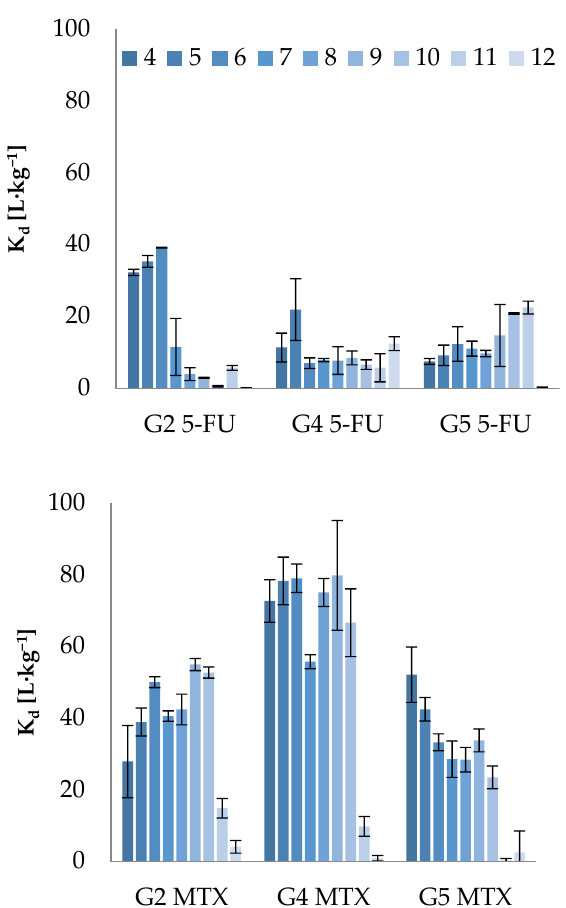
Figure 3. The influence of pH on the sorption potential of 5-FU and MTX (Basic conditions: medium: 0.01 M CaCl 2 ; pH range from 4 to 12; concentration level of ADs: 5 µ g · mL − 1 ; adsorption equilibrium time: 24 h; optimal S/L ratio: 5-FU (G2 soil = 1:25; G4 and G5 soil = 1:5); MTX (G2, G4, G5 soil = 1:15).